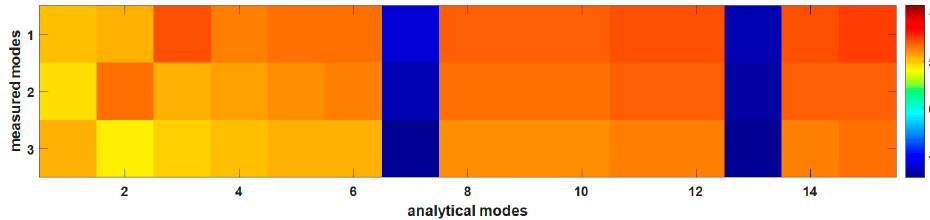
Figure 20. Sensitivity index of damage case I versus MCs 𝑁 𝑖 = 15 and 𝑁 𝑗 = 3 .